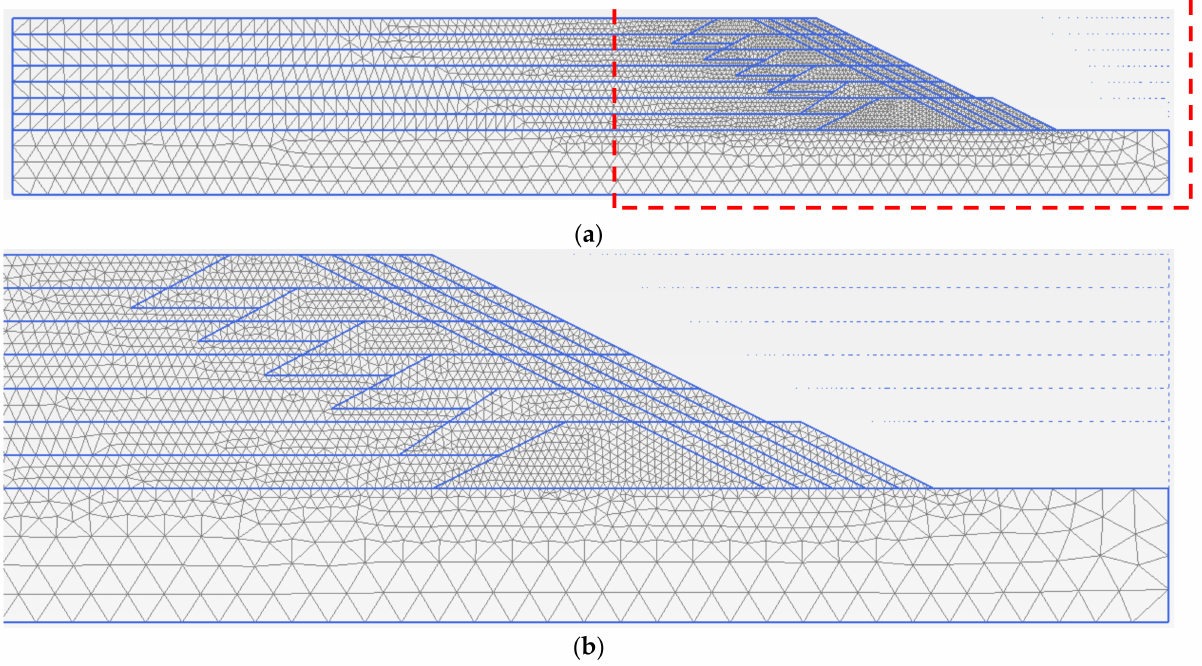
Figure 2. Finite element mesh of the upstream tailings dam: ( a ) full model and ( b ) upscaled model (downstream